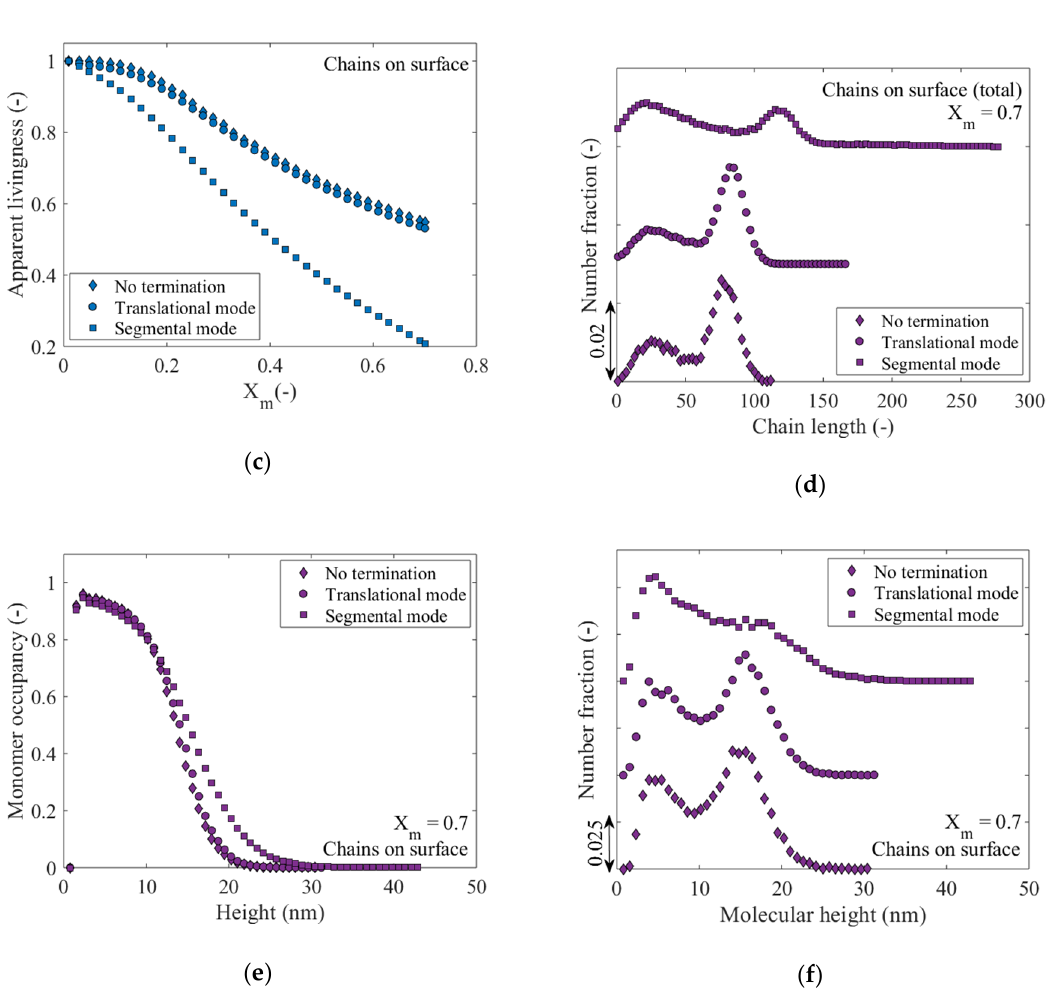
Figure 11. Theoretical evaluation of the effect of termination modes for solution-surface termination: (i) translational mode highlighting the case that a chain has to diffuse directly in an available space in the polymer layer (circles), (ii) segmental mode highlighting the case that a chain can alter locally its configuration in the available space (squares), as well as (iii) the reference case of absence of such termination reactions (diamonds) for the SI-RDRP process under conditions other than those in Figure 4 and parameters in Table 1. ( a ) ln ([ M lat ] / [ M lat ] ) vs time. ( b ) End-group functionality of the surface-tethered polymer chains ( EGF surf ) and ( c ) apparent livingness of the polymer layer. ( d ) Number of chain length distributions of the surface-tethered polymer chains at X m = 0.7. ( e ) The monomer occupancies along the lattice height in nm at X m = 0.7 and ( f ) the molecular height distributions (MHDs) at X m = 0.7.